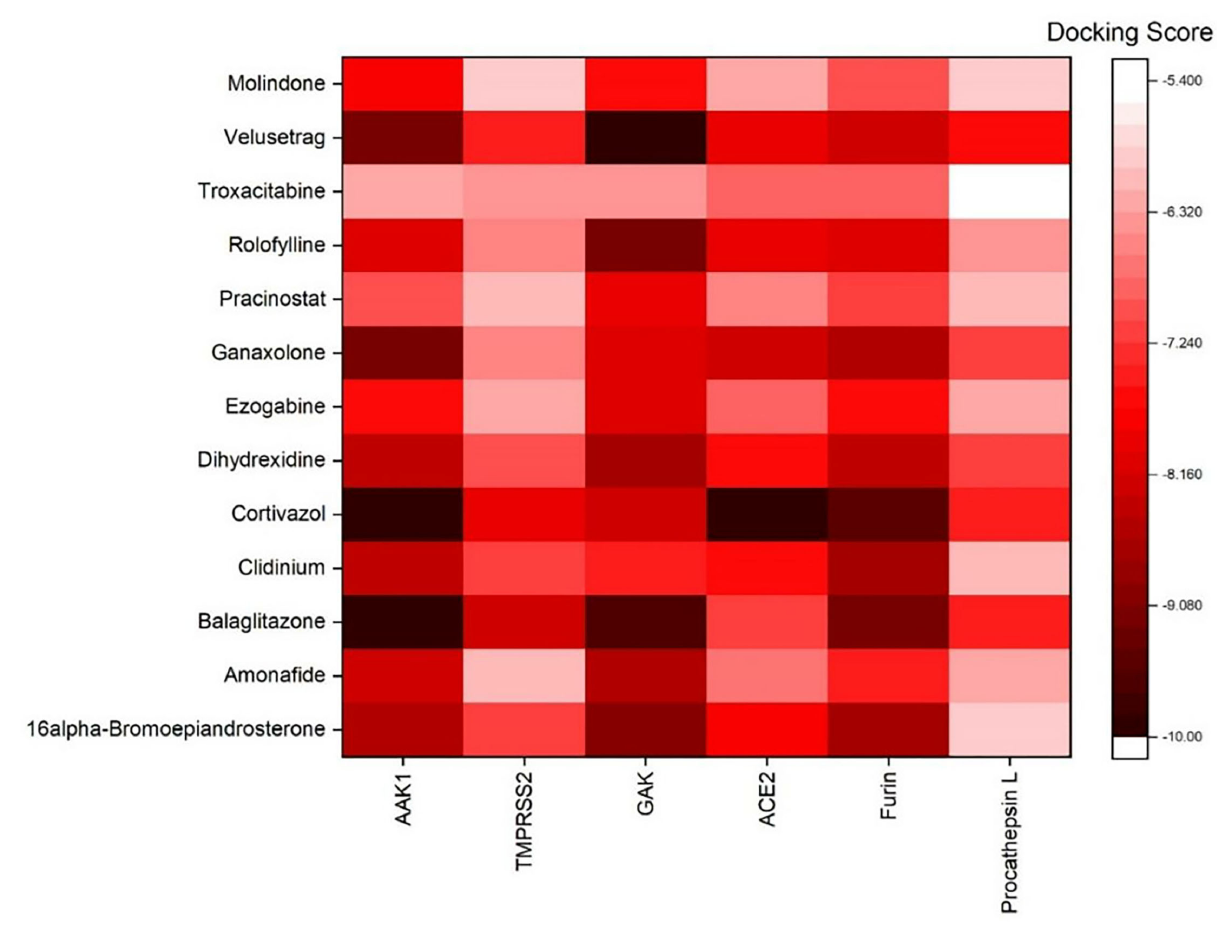
performed the best and for Furin, Cortivazol ( 1 G 9.4 in Figure 5 . This indicates the binding interaction along with = − the different host protein targets, their residues, and interaction scores highlighted in Figure 5 . Based on the docking scores, small-molecule drugs ( Table 6 ), such as Balaglitazone, are suggested for preclinical validation against Adaptor Protein 2- Associated Kinase 1 (AAK1) ( Figure 5A ), Cyclin-G-Associated Kinase (GAK) ( Figure 5C ), and Furin ( Figure 5H ). Similarly, the other top-ranked candidate drug Cortivazol is recommended against host COVID-19 targets, such as Adaptor Protein 2- Associated Kinase 1 (AAK1), Furin, and Angiotensin-Converting Enzyme 2 (ACE2), followed by Velusetrag, recommended for Cyclin-G-Associated Kinase (GAK) ( Figure 5D ), and Adaptor Protein 2-Associated Kinase 1 (AAK1) ( Figure 5I ); 16 alpha Bromoepiandrosterone is suggested for Furin ( Figure 5G ) as well as for Cyclin-G-Associated Kinase